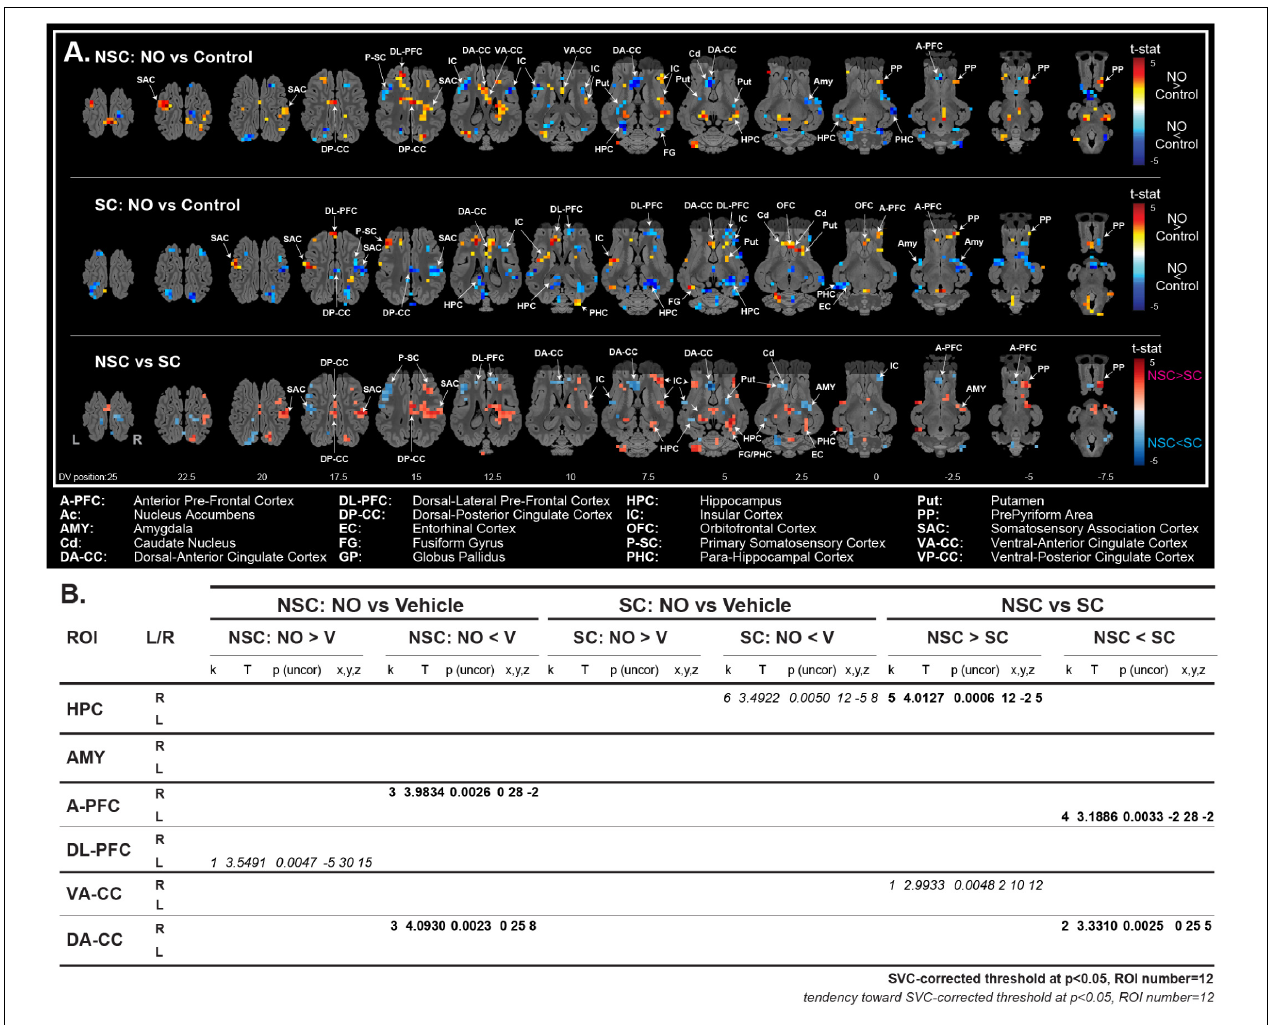
FIGURE 6 | Brain metabolism and function. The BOLD response to the stimulation with a new odorant (NO) was significantly higher in the right HPC and lower in the left A-PFC and right DA-CC of non-stressed (NSC) compared to stressed (SC) animals ( A , brain activation maps; B , coordinates and statistical values of significant clusters). N = 8/group, Single Voxel Corrected (SVC) threshold at p < 0.05, Regions of interest (ROI) number =